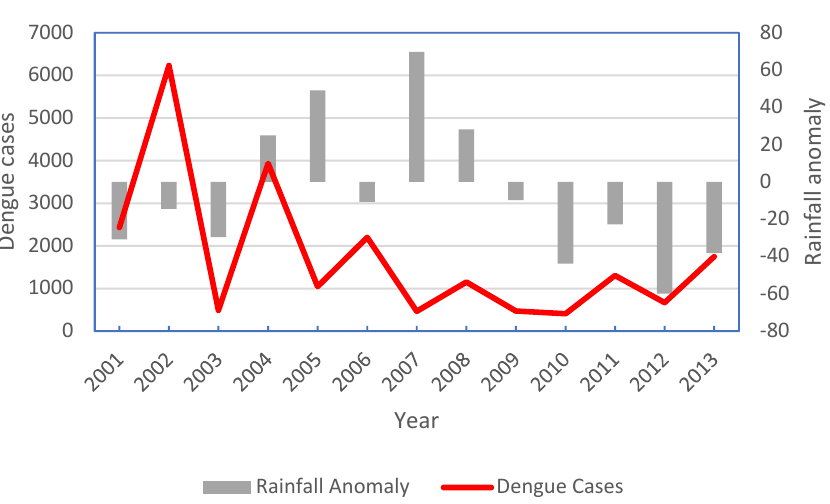
Figure 6. Distribution of rainfall anomaly vs. dengue cases in the city of Dhaka, Bangladesh for the 13-year study period (2001–2013).